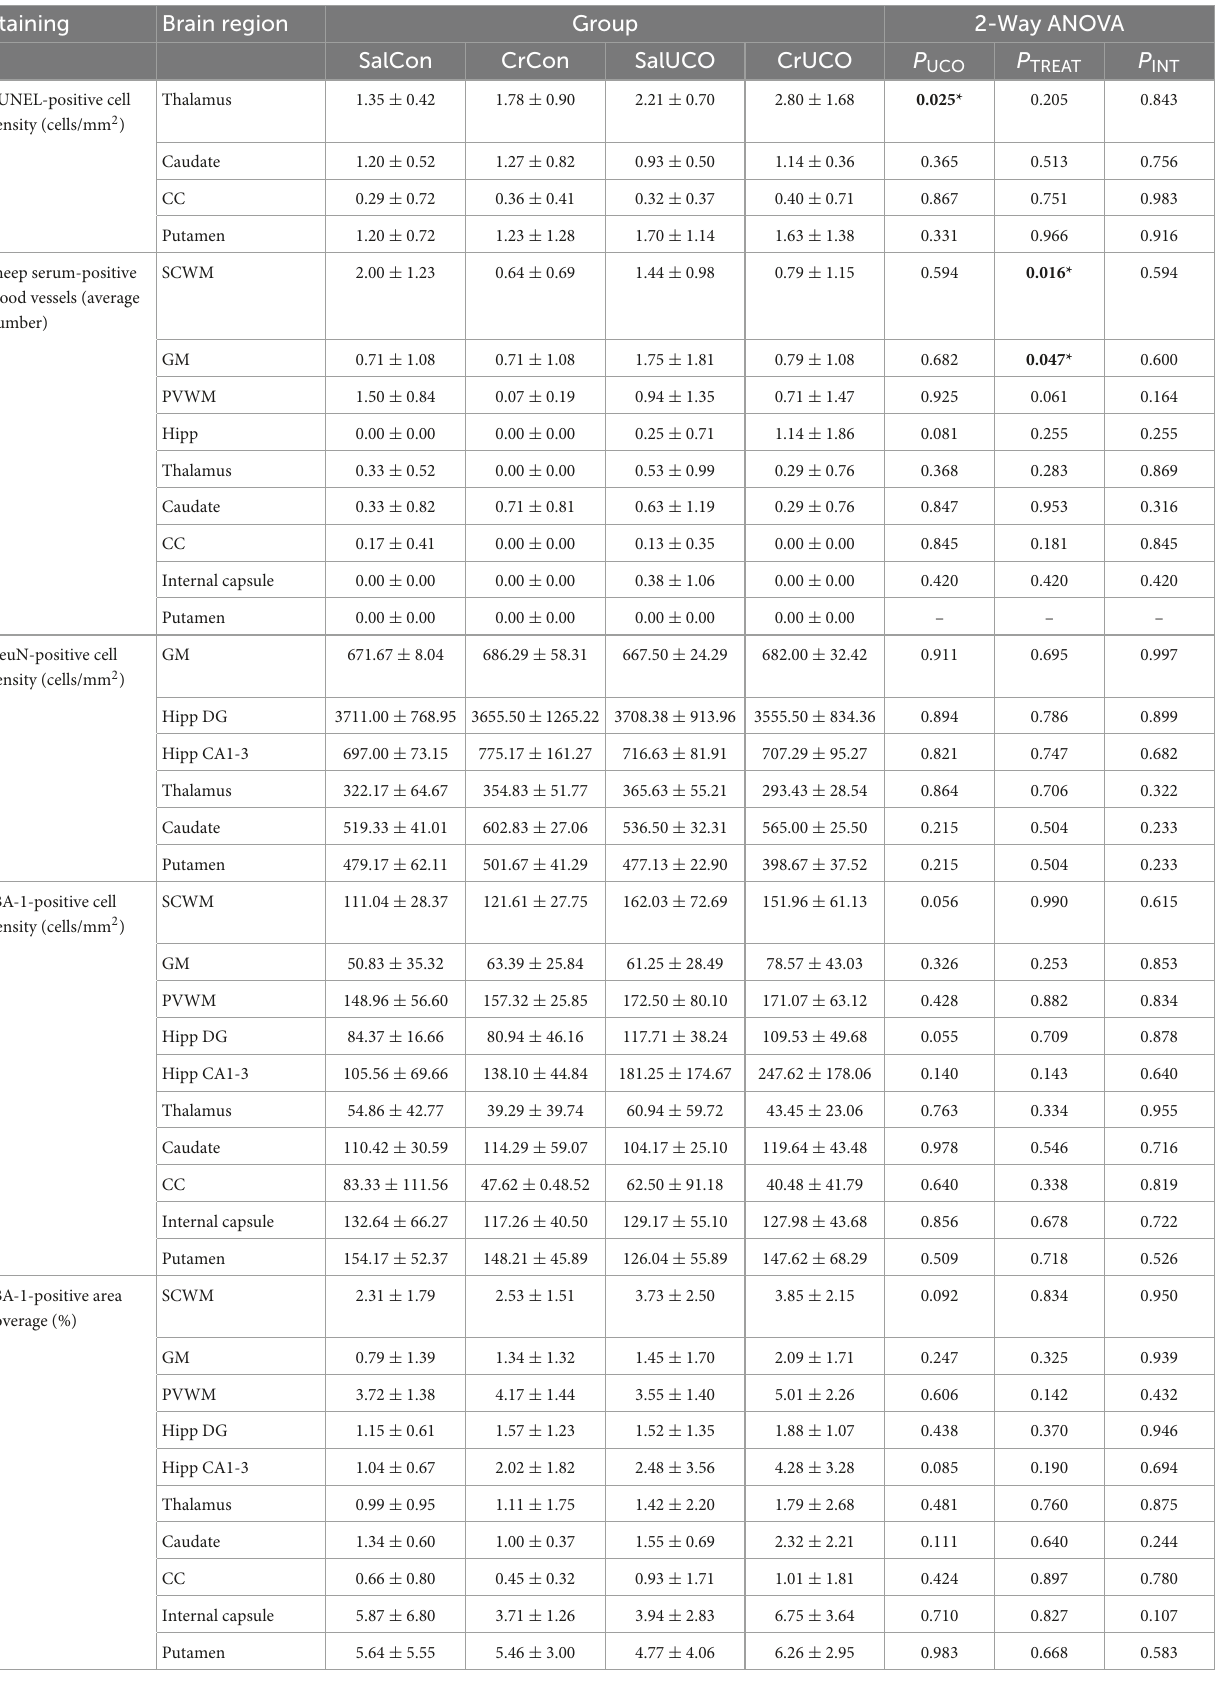
TABLE 2 Neuropathological effects of umbilical cord occlusion (UCO) and/or creatine treatment.